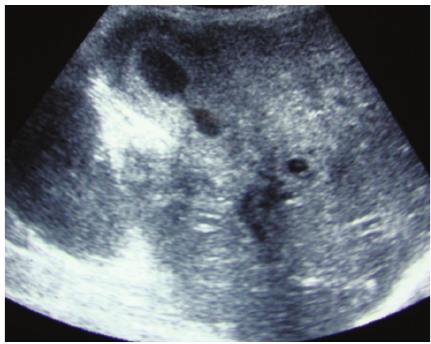
Figure 1: Ultrasound showing smooth uniform thickening of gall- bladder wall.